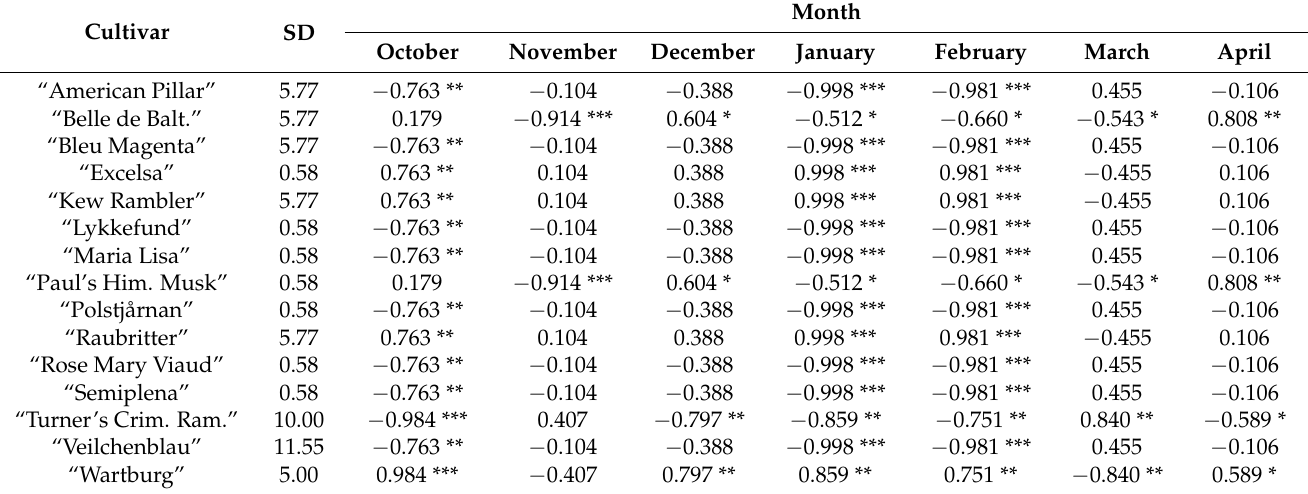
Table 5. Part of matrices of effect correlations between average monthly air temperature (2005/2006, 2009/2010, and 2015/2016) and timing of the first leaf pair unfolding, not yet at full size, and light green and/or bronze (BBCH 11) in color in rambler